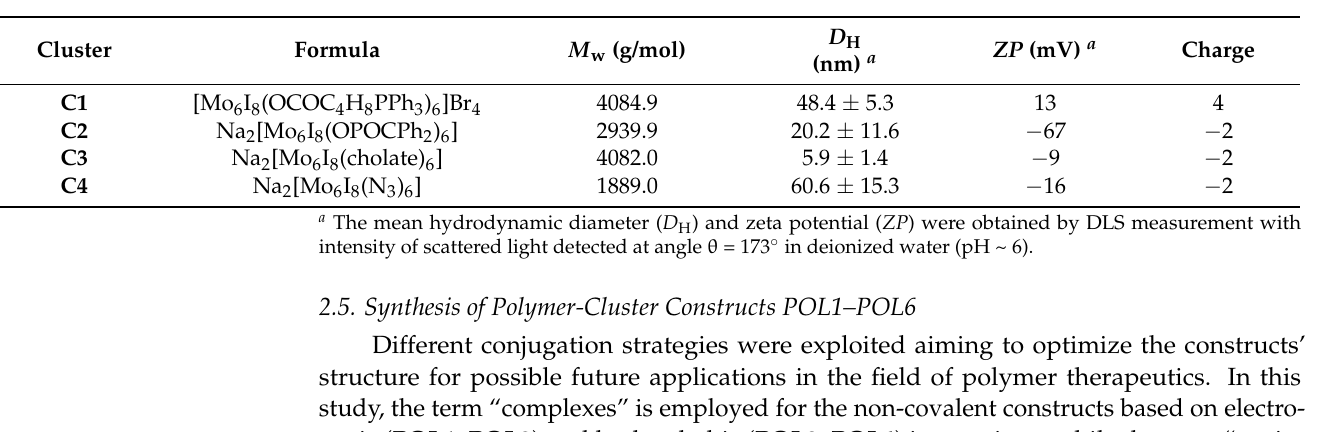
Table 2. Physico-chemical characteristics of Mo 6 clusters.